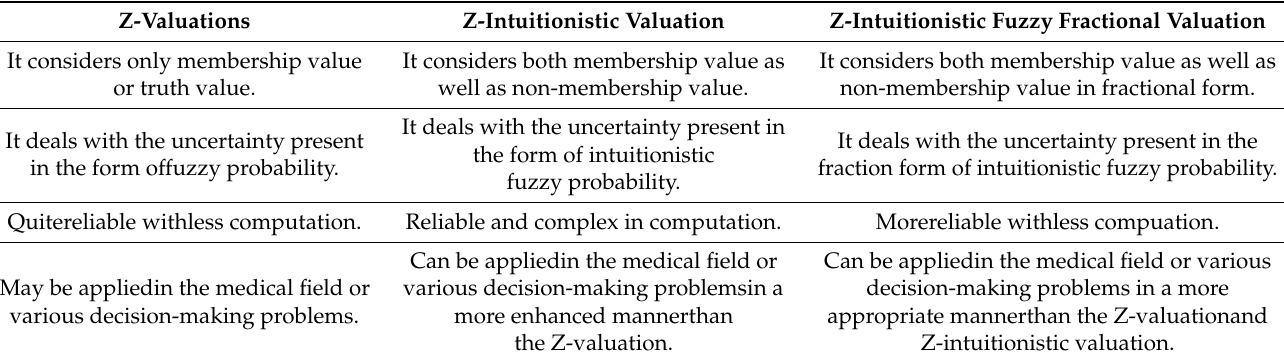
Table 2. Comparative study of existing techniques with proposed